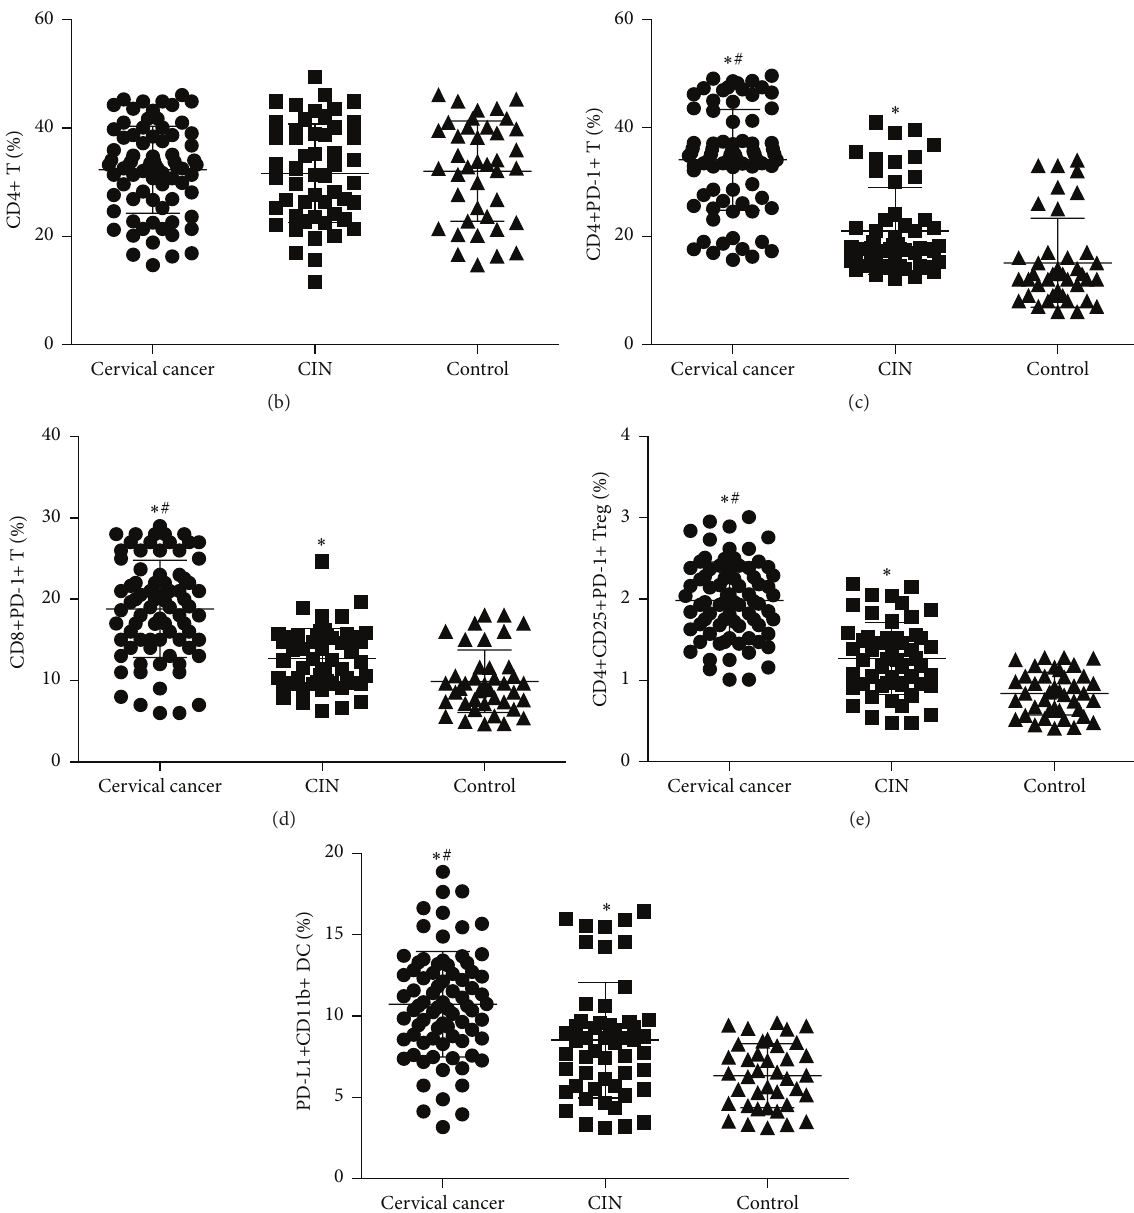
Figure 1: PD-1 expression in T cells and PD-L1 expression in DCs. (a) Representative flow cytometric plots for the measurements of the contents of (b) CD4+T, (c) CD4+ PD-1+T, (d) CD8+ PD-1+T, (e) CD4+CD25+PD-1+Treg, and (f) PD-L1+CD11b+DC in normal control, CIN, and cervical cancer groups. ∗ 𝑃 < 0.05 compared with control group; # 𝑃 < 0.05 compared with CIN